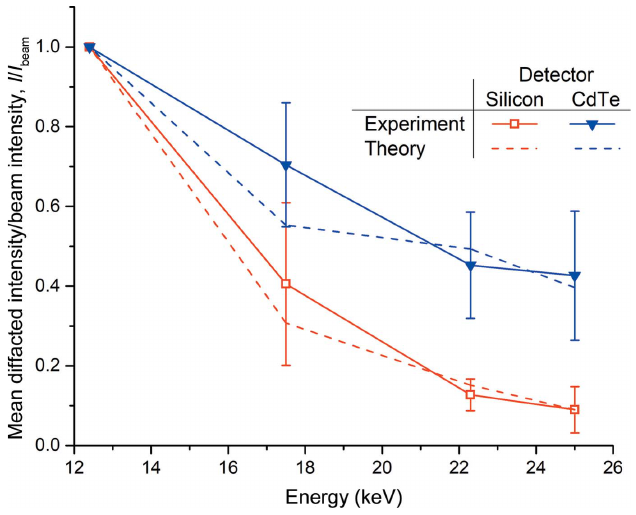
Figure 1 Ratio of diffracted intensity to beam intensity ( I / I beam ) as a function of energy for data recorded using both the CdTe EIGER and Si PILATUS detectors. Experimental data are the mean of 22 and seven data sets for the EIGER and PILATUS detectors, respectively. The predicted energy dependence of I / I beam determined from theory using the measured fluxes and beam sizes is overlaid. To highlight the energy dependence of I / I beam , the data are normalized to 12.4